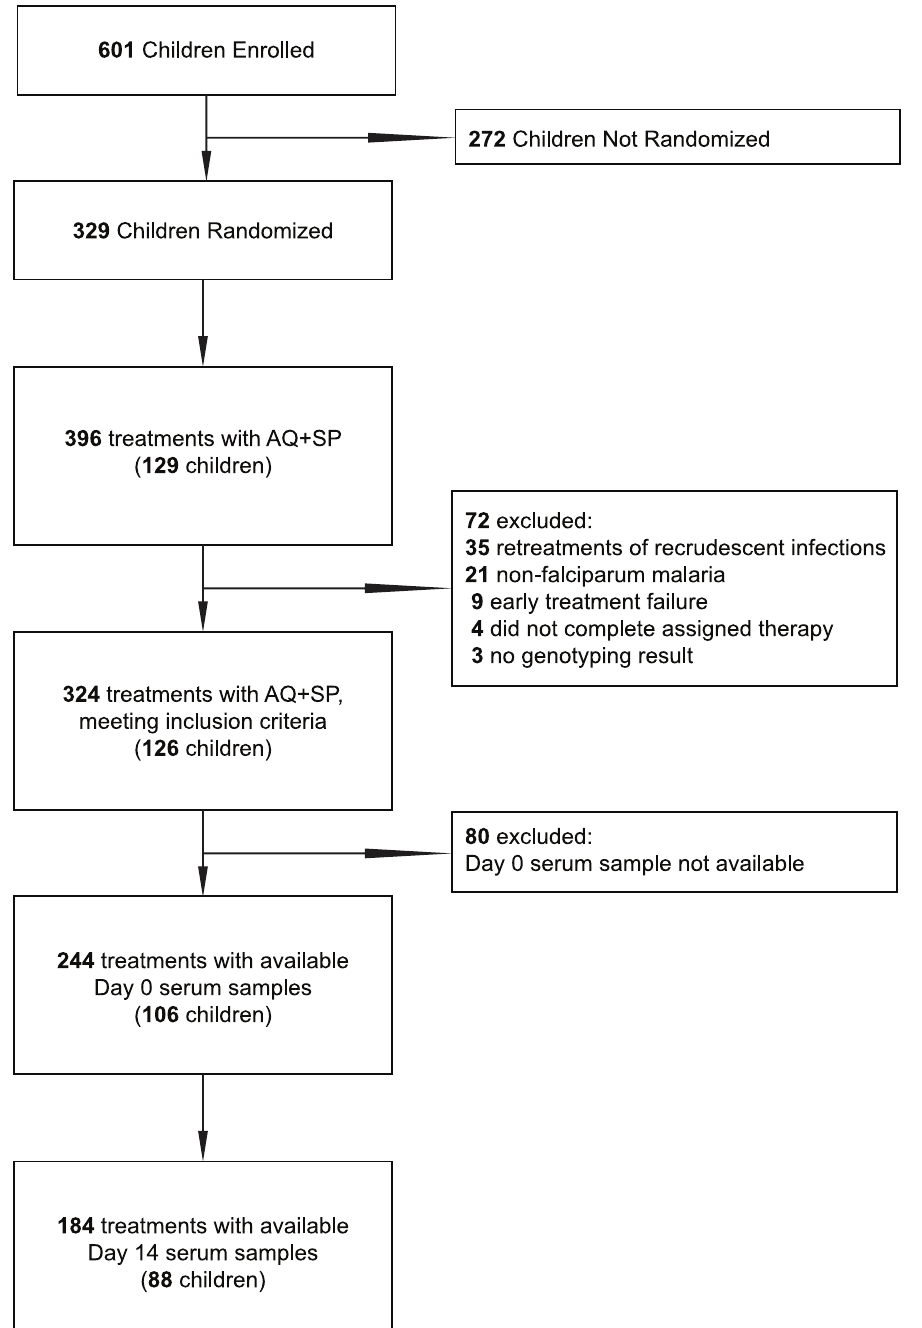
Figure 1. Sample inclusion. Malaria treatments with amodiaquine + sulfadoxine-pyrimethamine (AQ + SP) and available samples for inclusion in the study. Further details on children not randomized have been previously described [17].